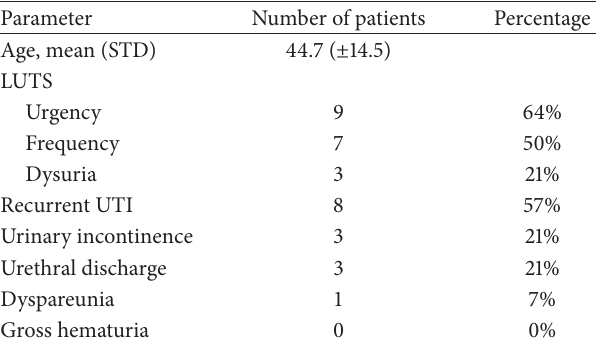
Table 1: Clinical data for women undergoing surgical resection of urethral diverticula.